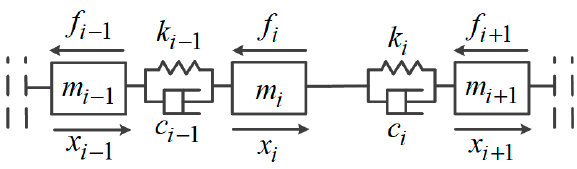
Figure 2. Dynamic model of conveyor belt unit i .